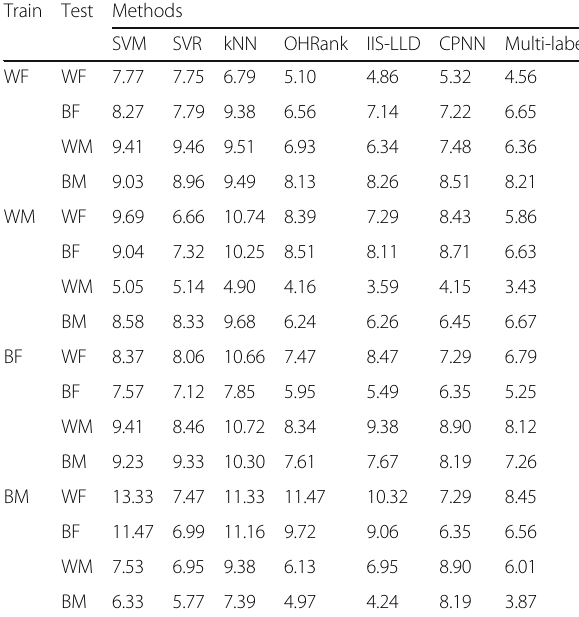
Table 3 MAE results of Refined-MORPH dataset